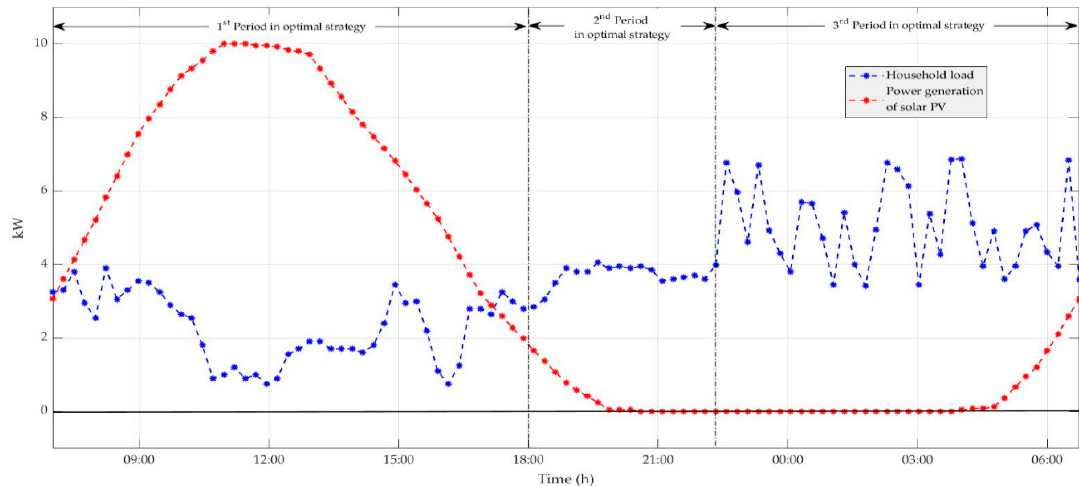
Figure 8. The electrical energy cost of each time slot and daily electrical energy cost for the consumer.